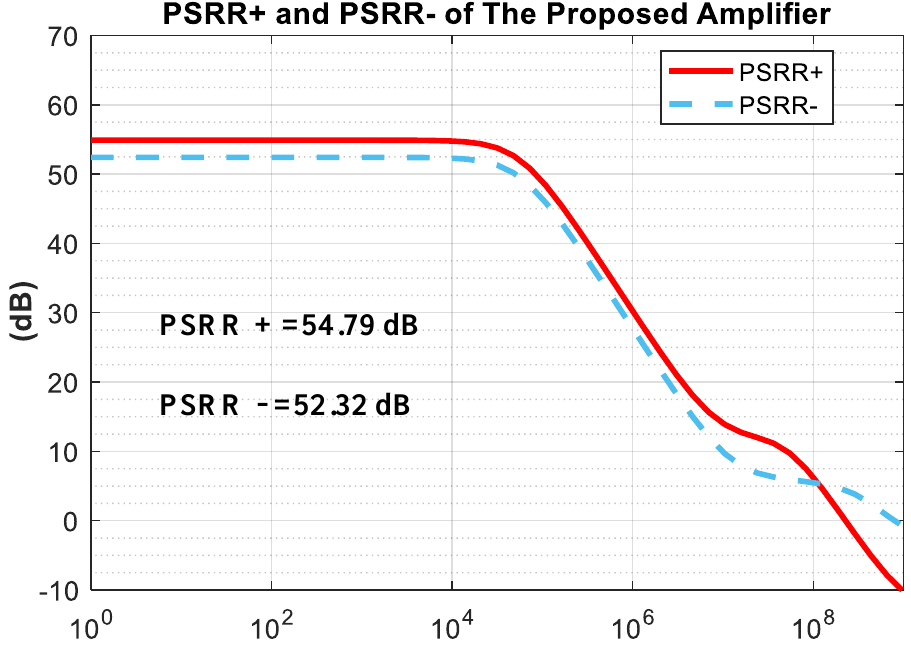
Figure 10. PSRR+ and PSRR- of the proposed inverter-based amplifier.